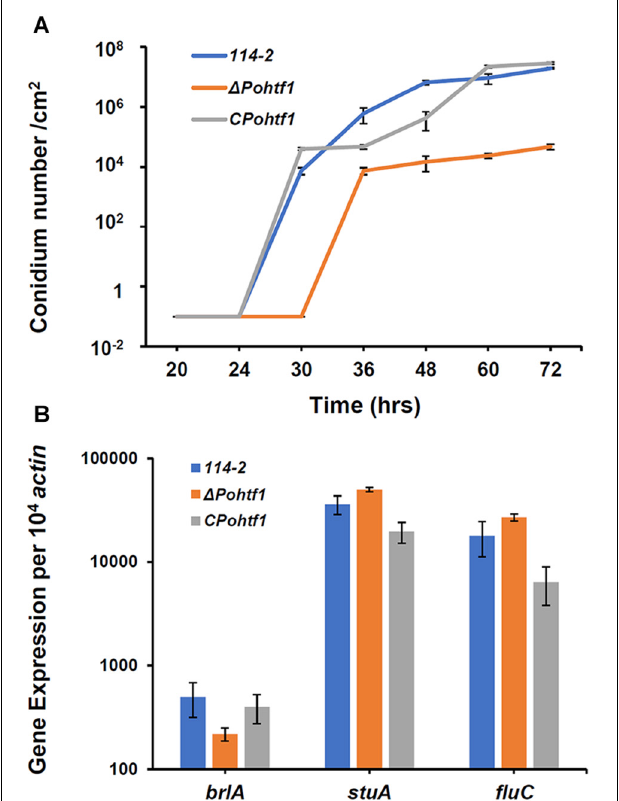
FIGURE 5 | The effects of Po Htf1 on conidiation. (A) The conidiation curve of P. oxalicum 114-2, (cid:49) Pohtf1 and C Pohtf1 on glucose plates. The plates were incubated at 30 ◦ C, and the spore numbers in a fixed area were counted at 24, 30, 36, 48, 60, and 72 h. (B) Expression of the major asexual development transcriptional regulators. All strains were incubated in the cellulase production medium for 4 h. The expression levels of brlA , stuA and fluC were measured by